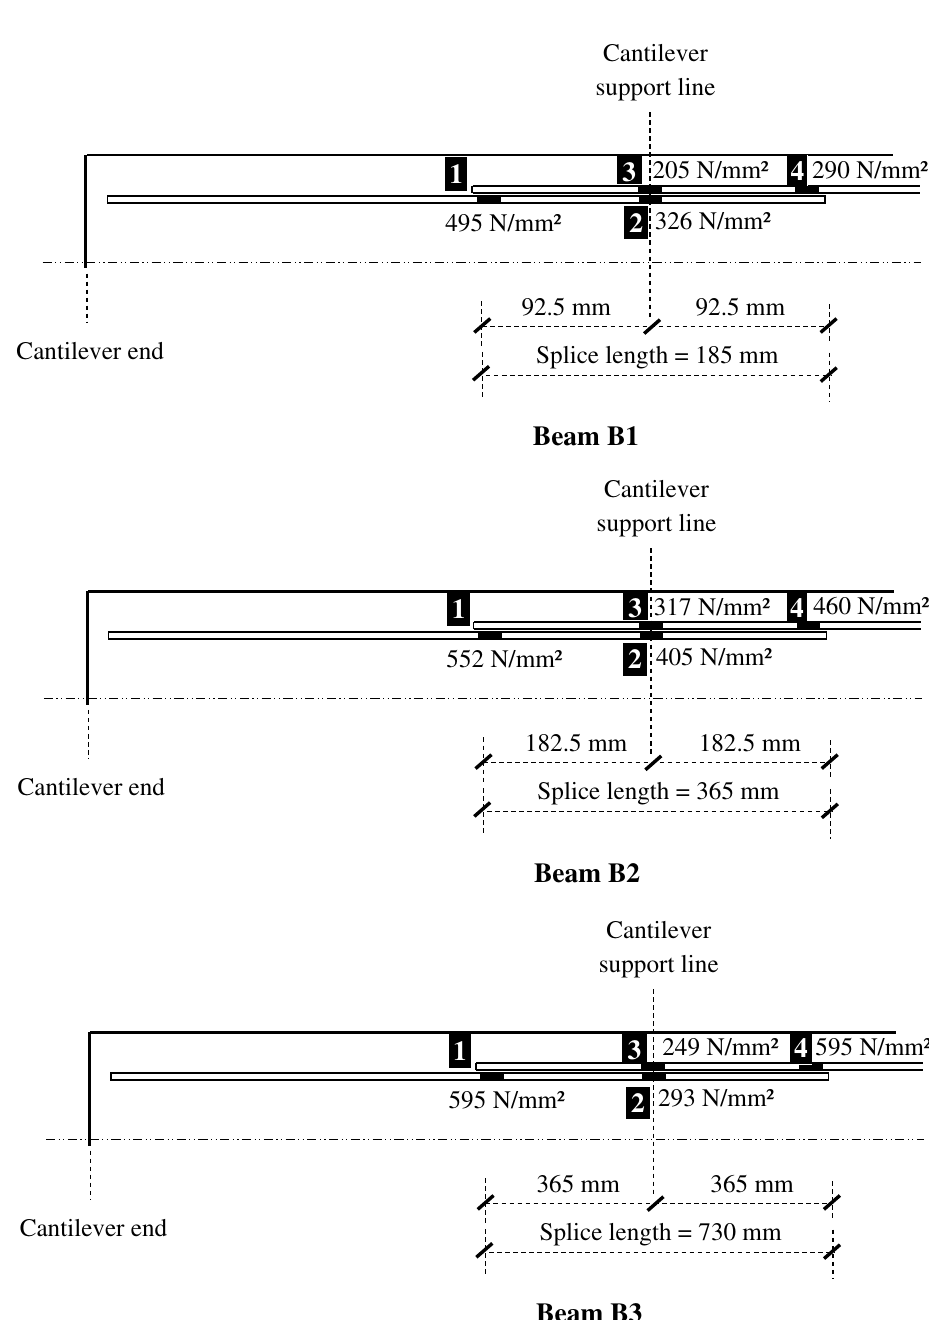
Fig. 9 Ultimate steel stress values calculated from steel strains at strain gauges’ locations. Values over 586 N/mm 2 indicate yielding. (Shear links omitted for clarity) Not to